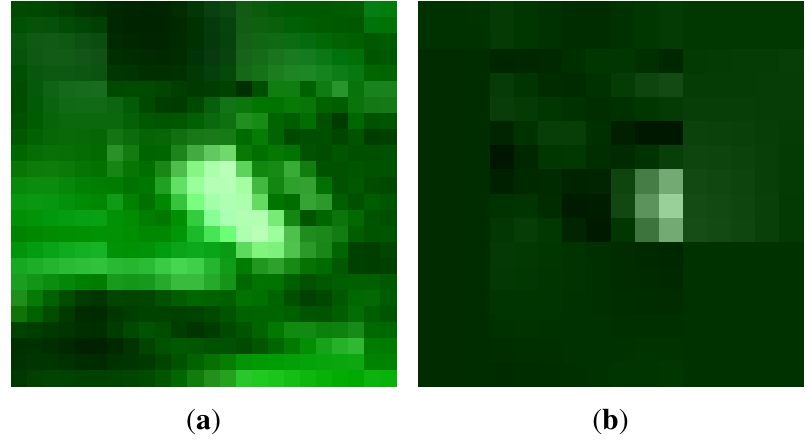
Figure 3. Magnified examples of real laser spots. ( a ) Moving laser spot on an irregular surface; ( b ) laser spot at a long